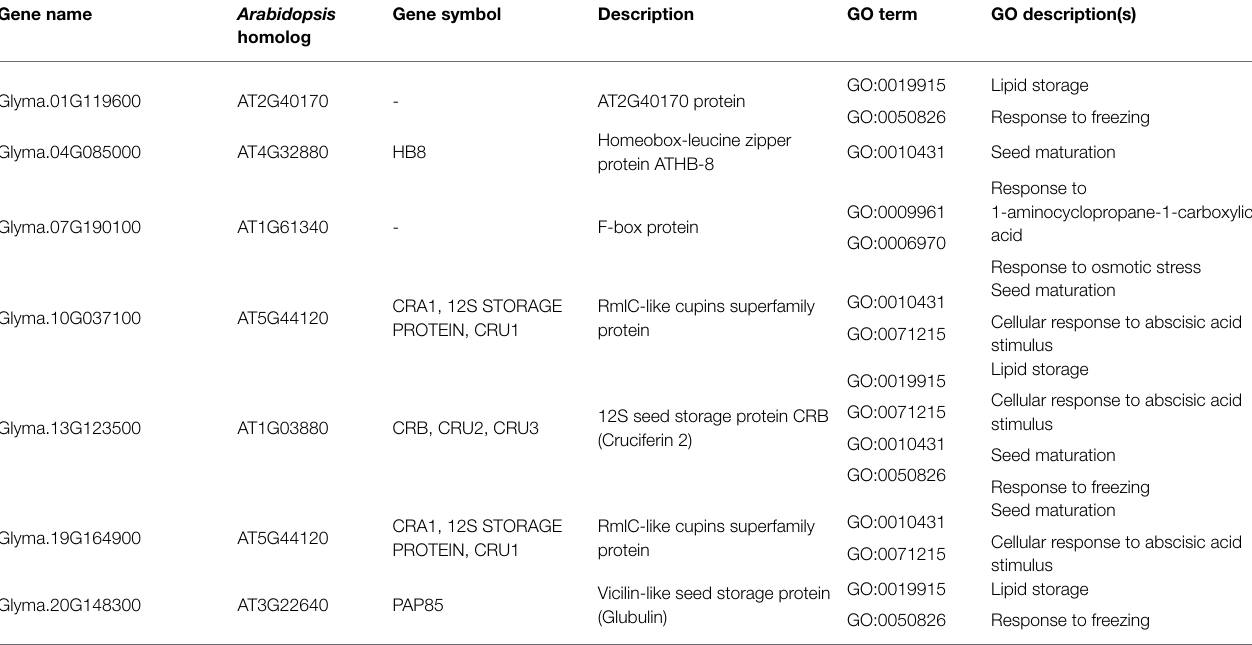
TABLE 4 | Putative target genes in the MRP subset with annotations for observed significant GO categories validated by Arabidopsis DAP-seq dataset and motif sequence